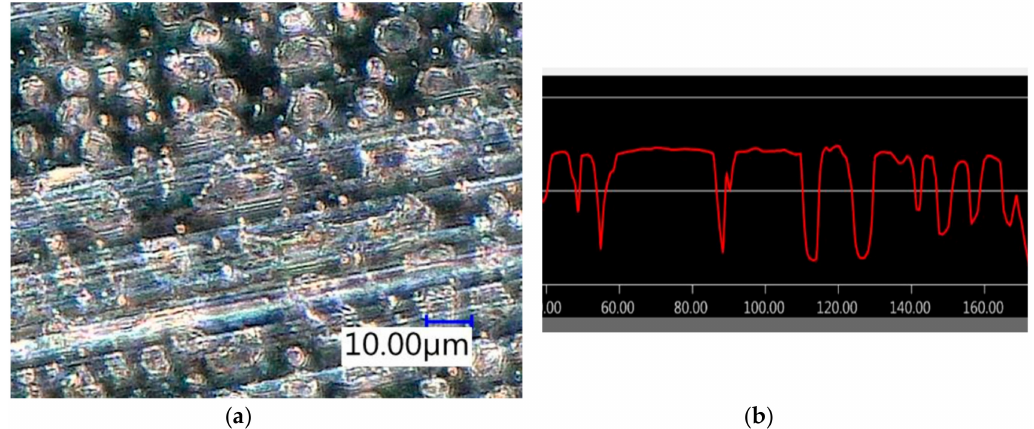
Figure 13. Microstructure ( a ) and profile ( b ) of machined surface under MQCL condition with emulsion-based nanofluid of MoS 2 0.5 wt